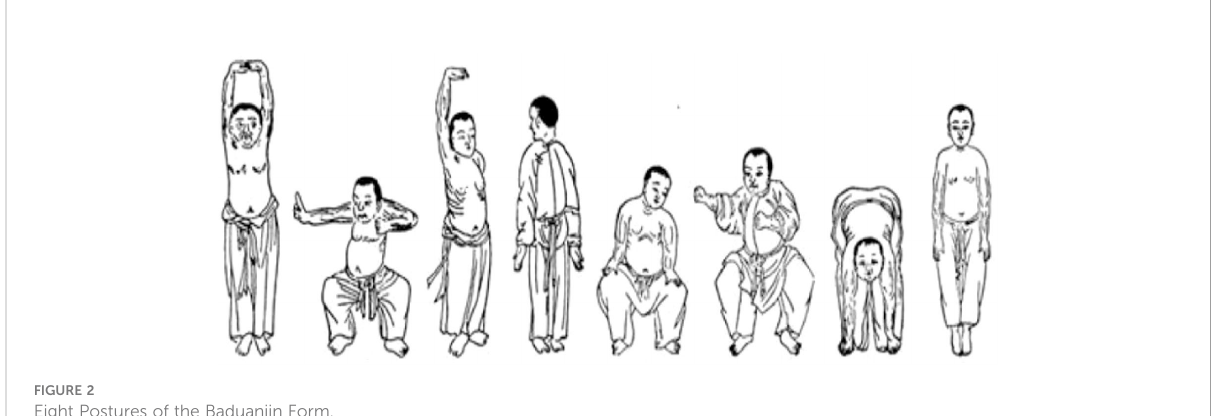
FIGURE 2 Eight Postures of the Baduanjin